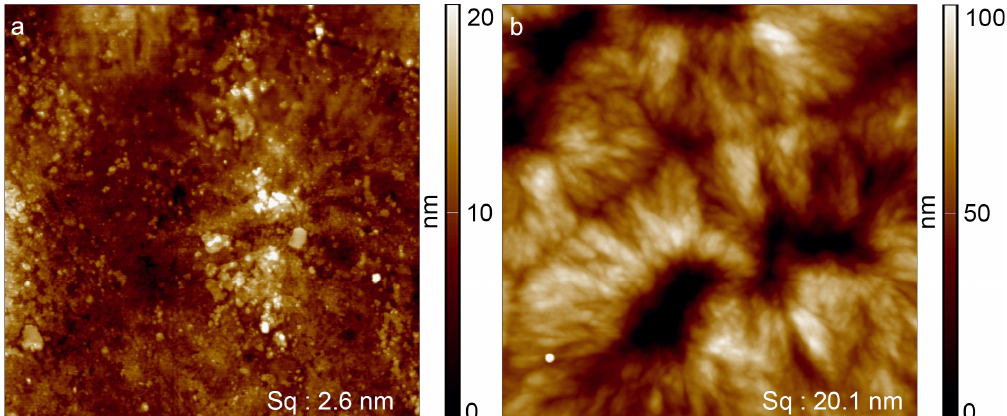
Figure 3. AFM images of PA 12 before and after atmospheric plasma jet treatment. The images have an edge length of 10 µ m. ( a ) Unmodified PA 12 surface with a roughness of 2.6 nm (S q ). ( b ) PA 12 surface after modification with a plasma containing acrylic acid at atmospheric pressure, with a roughness of 20.1 nm (S q ).